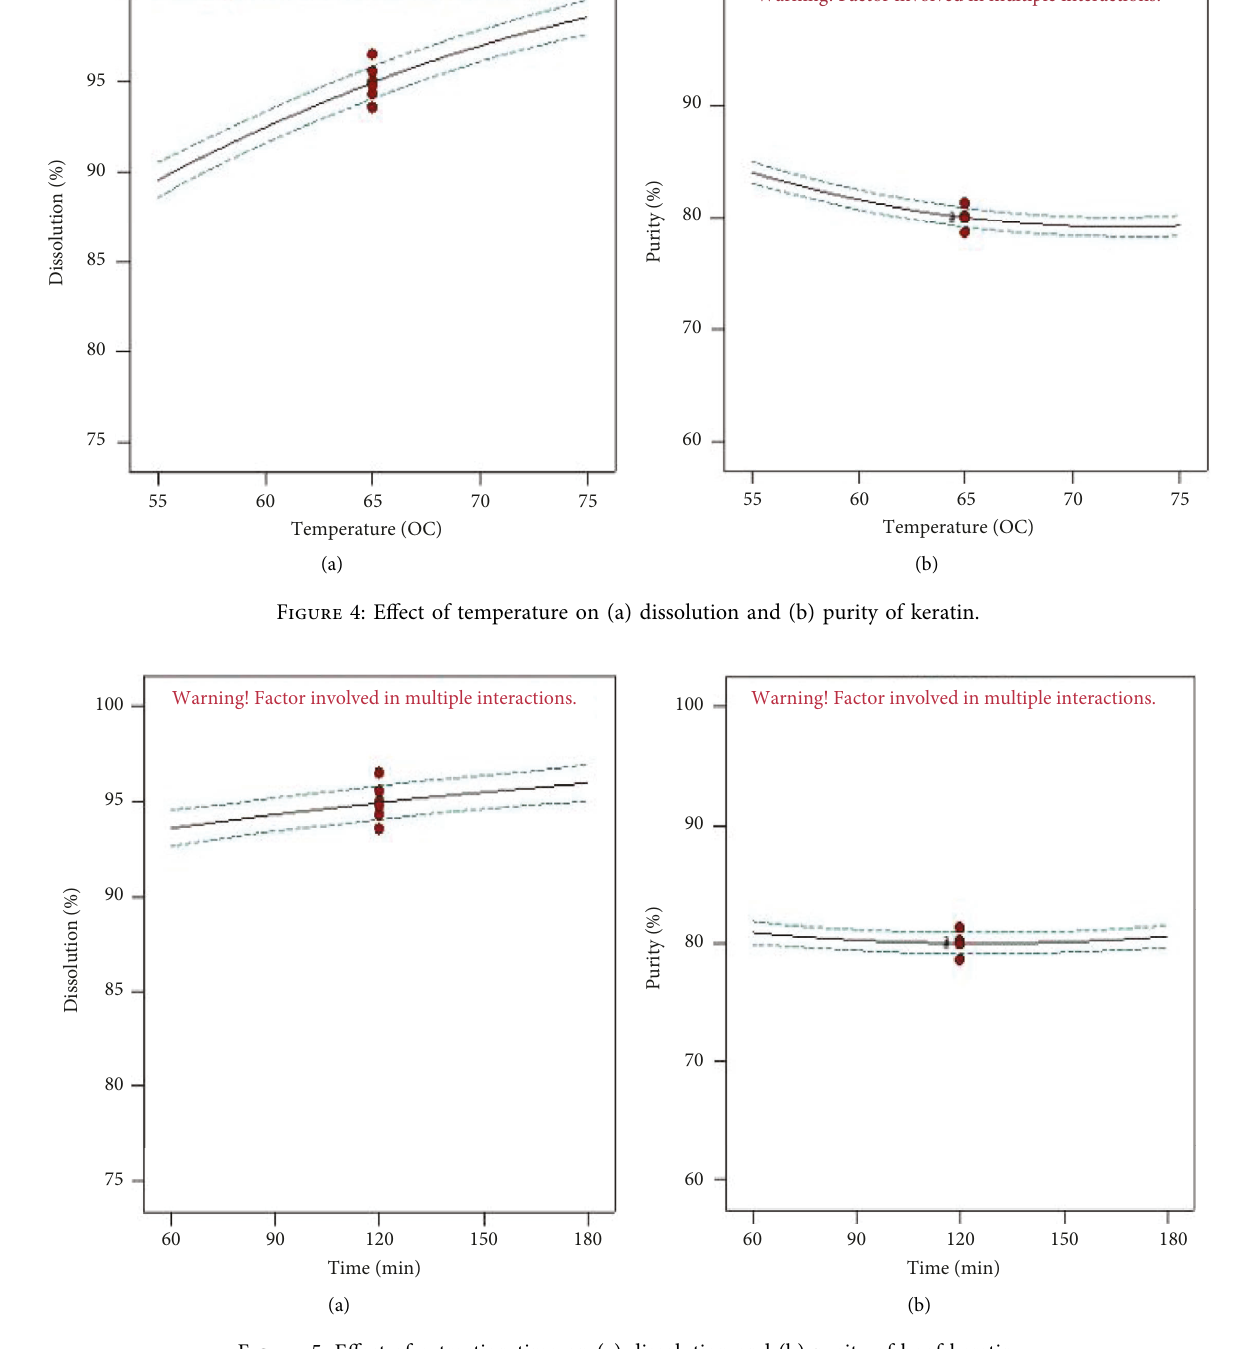
Figure 5: Effect of extraction time on (a) dissolution and (b) purity of hoof